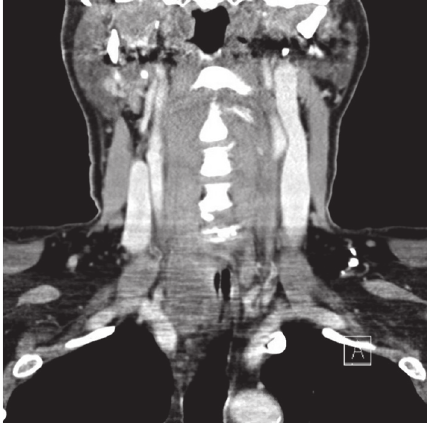
Figure 6: First CT scan of the neck after the initiation of pem- brolizumab, 4 doses (coronal image).